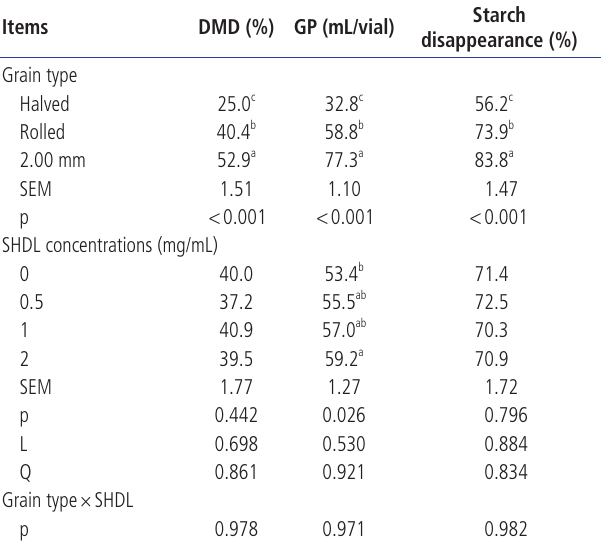
Table 3. Effects of sodium hydroxide dehydrated lignin (SHDL) at 0, 0.5, 1.0, and 2.0 mg/mL on the 12 h in vitro ruminal fermentation of barley grain processed by different methods